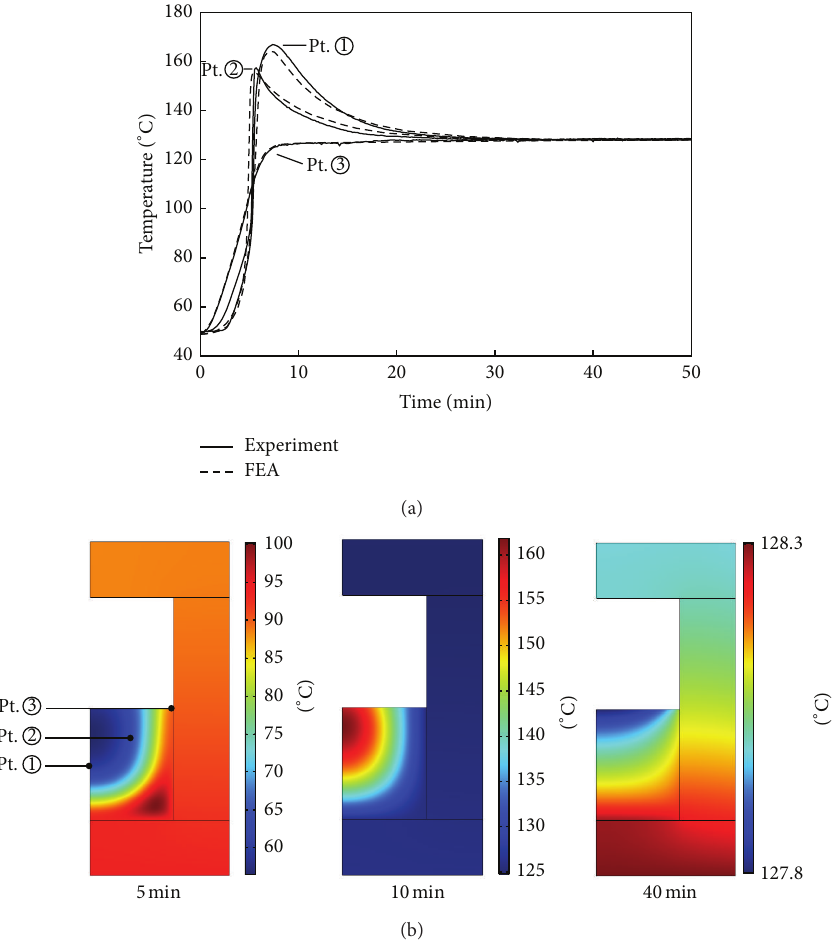
Figure 5: Comparison of the experimental data and simulation (points 1, 2, and 3). (a) Experiment and simulation. (b) Temperature contour (simulation).